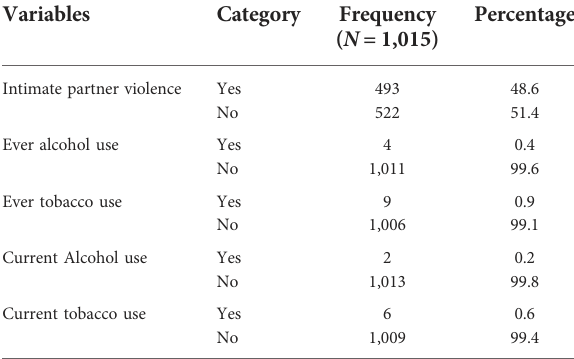
TABLE 2 Reproductive, obstetric, and gynecological characteristics of pregnant women at Kersa and Haramaya HDSS sites, 2021 ( n =1015)